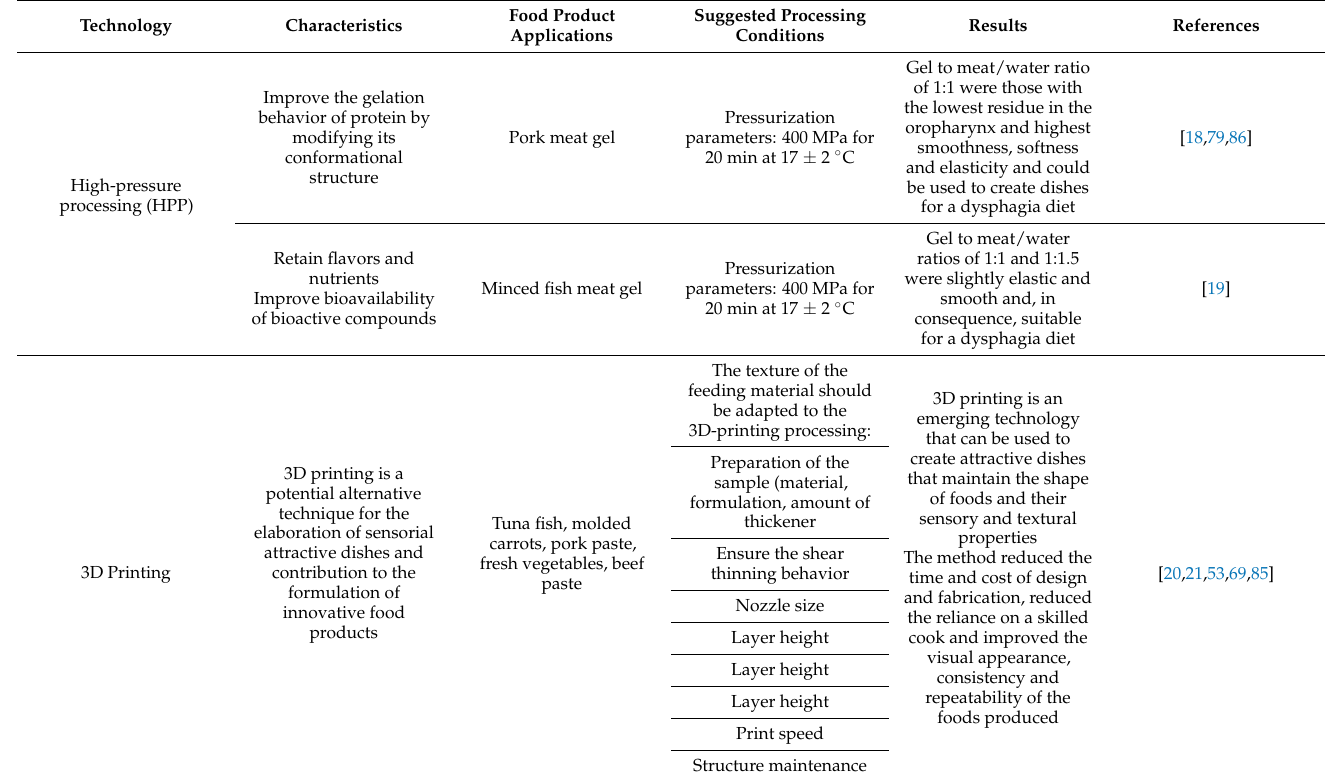
Table 3. Texture modification technologies used in dysphagia